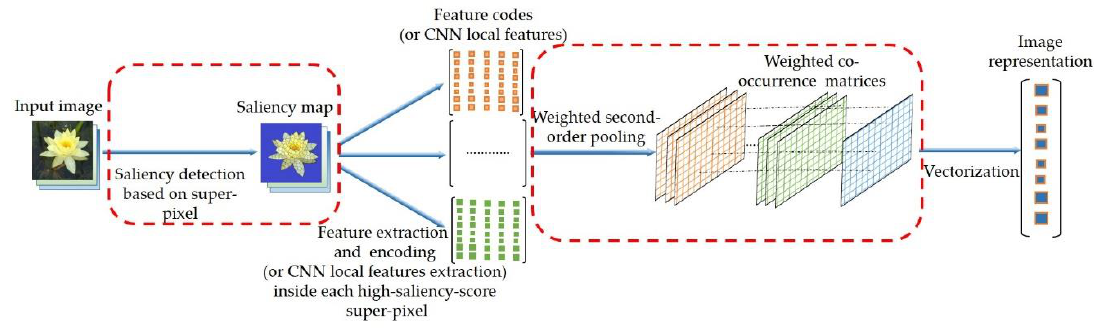
Figure 2. The overall architecture of the proposed representation model and its key modules. The two red bounding boxes denote the proposed modules. The left one denotes the saliency detection method and the right one indicates the weighted second-order pooling module.